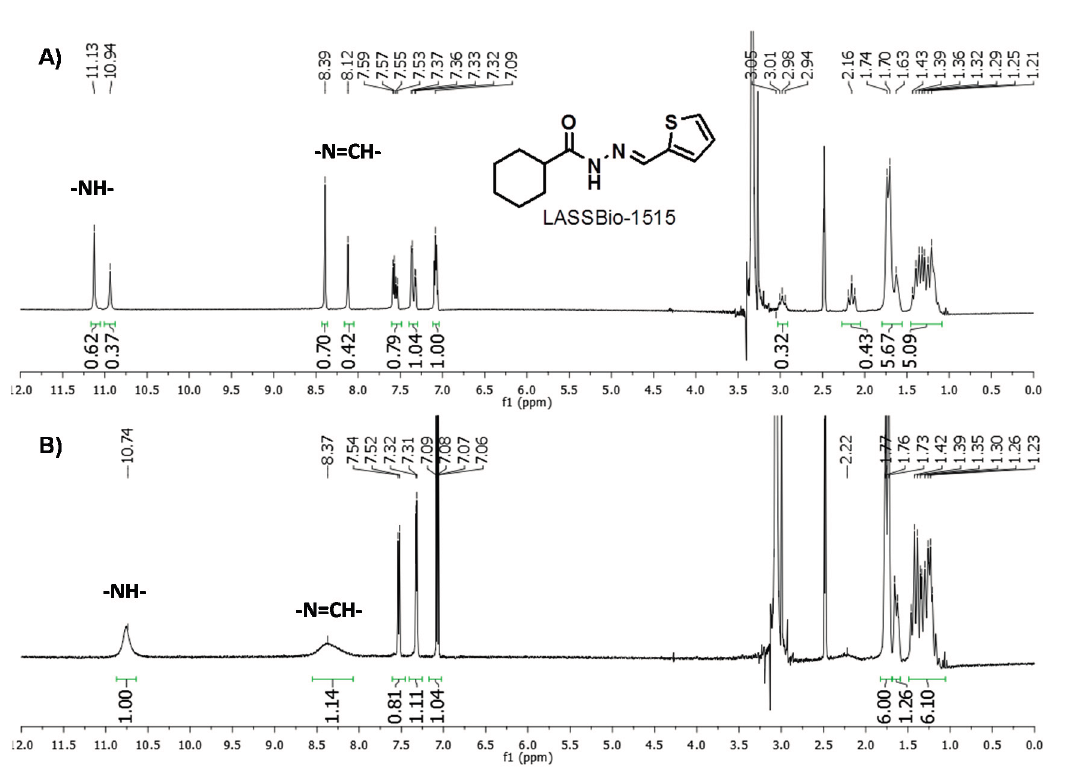
Figure 3. 1 H-NMR (300 MHz) spectra of the NAH derivative LASSBio-1515 ( 10 ) in DMSO d 6 at 25 °C ( A ) and 90 °C ( B